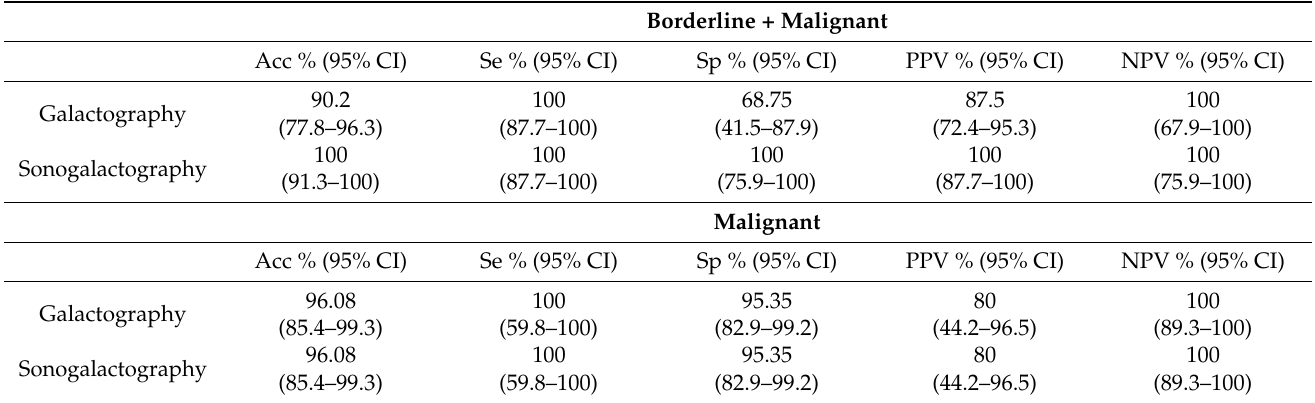
Table 3. Diagnostic efficiency of the galactography and the